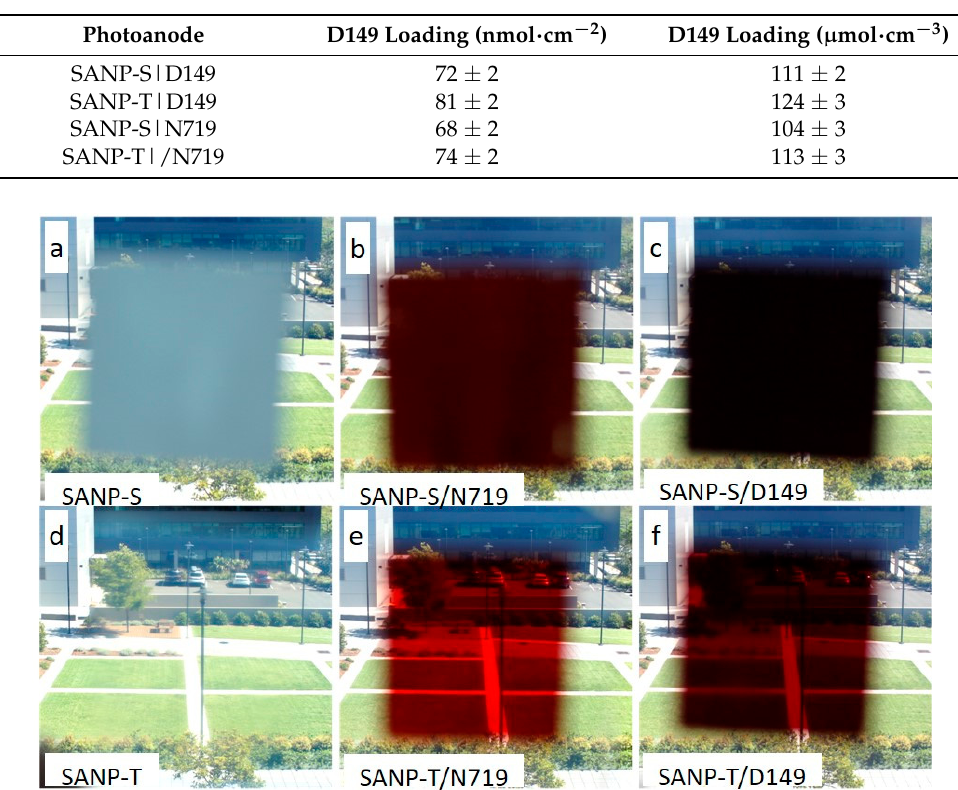
Figure 5. Visual images taken through 10 µ m-thick photoanode films of ( a – c ) SANP-S and ( d – f ) SANP-T, with ( a , d ) no sensitiser or ( b , e ) sensitised with N719 or ( c , f ) D149. Table 1. The amount of D149 dye loading on SANP-S and SANP-T films (thickness = 5.0 ± 0.3 μ m; area = 1 cm 2 ) calculated using the desorption method [31].